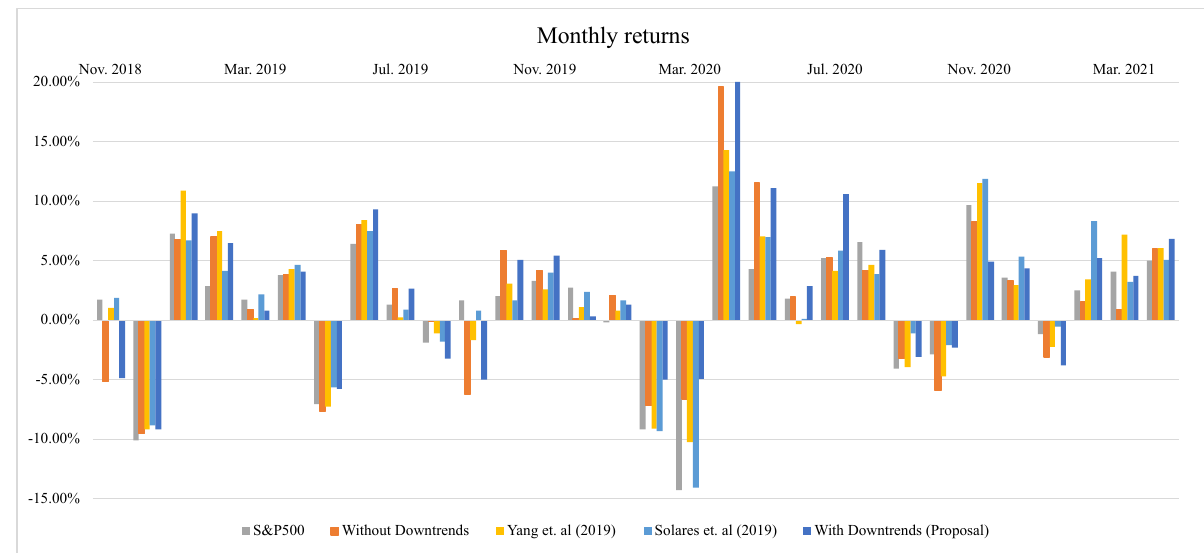
Figure 2. Monthly returns